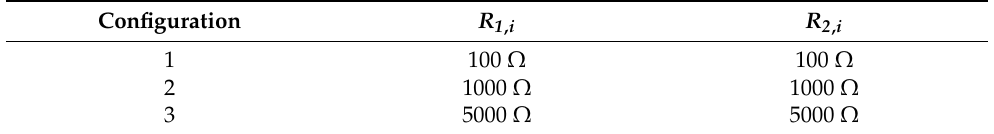
Table 1. Resistor configurations.